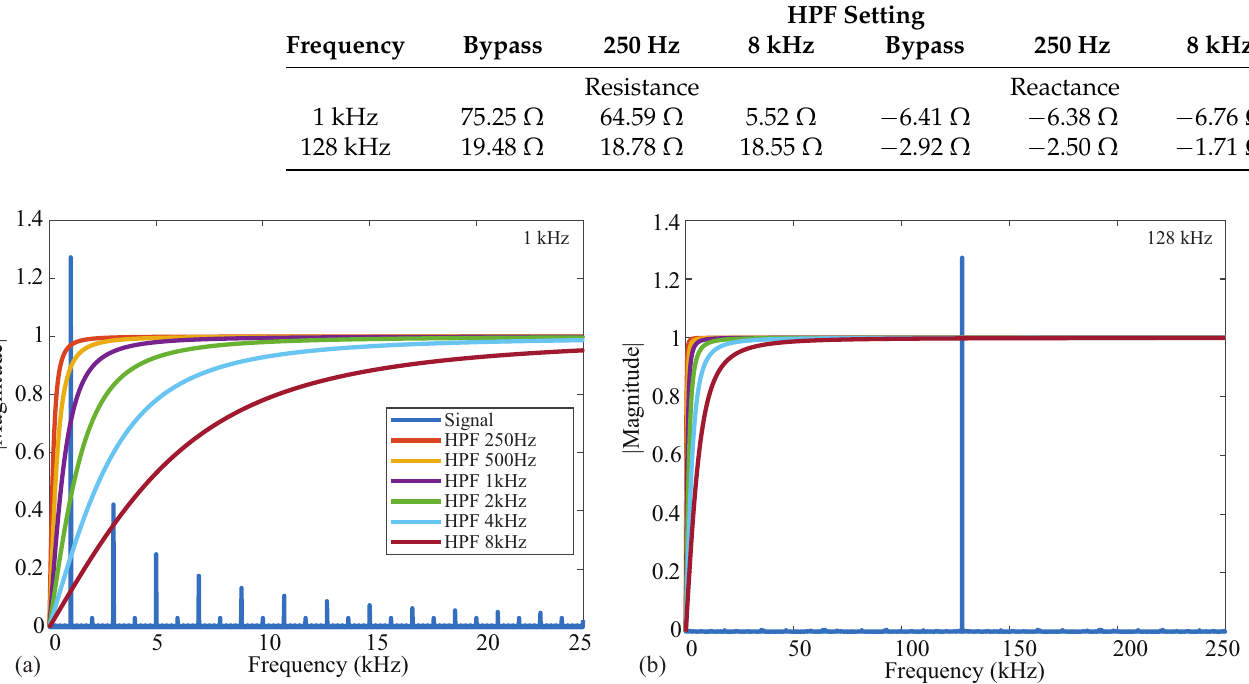
Table 2. Resistance and reactance measured in the 2 R − 1 C model at 1 and 128 kHz with and without MAX3000x high-pass filtering functionality.